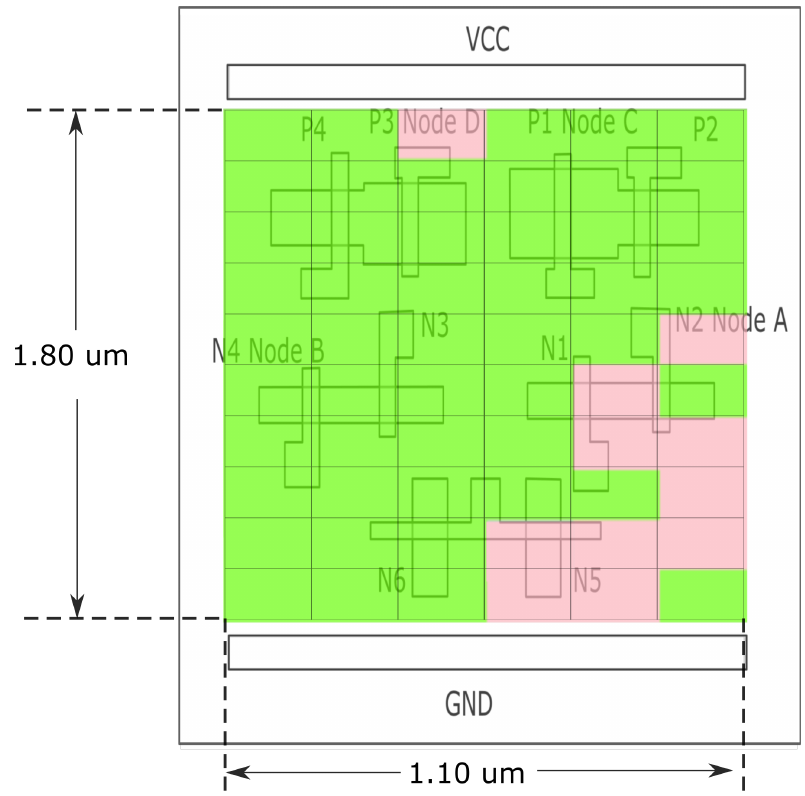
Figure 10. Sensitive map for Quatro design of SRAM with all ‘1’ stored data pattern and 90 pJ laser